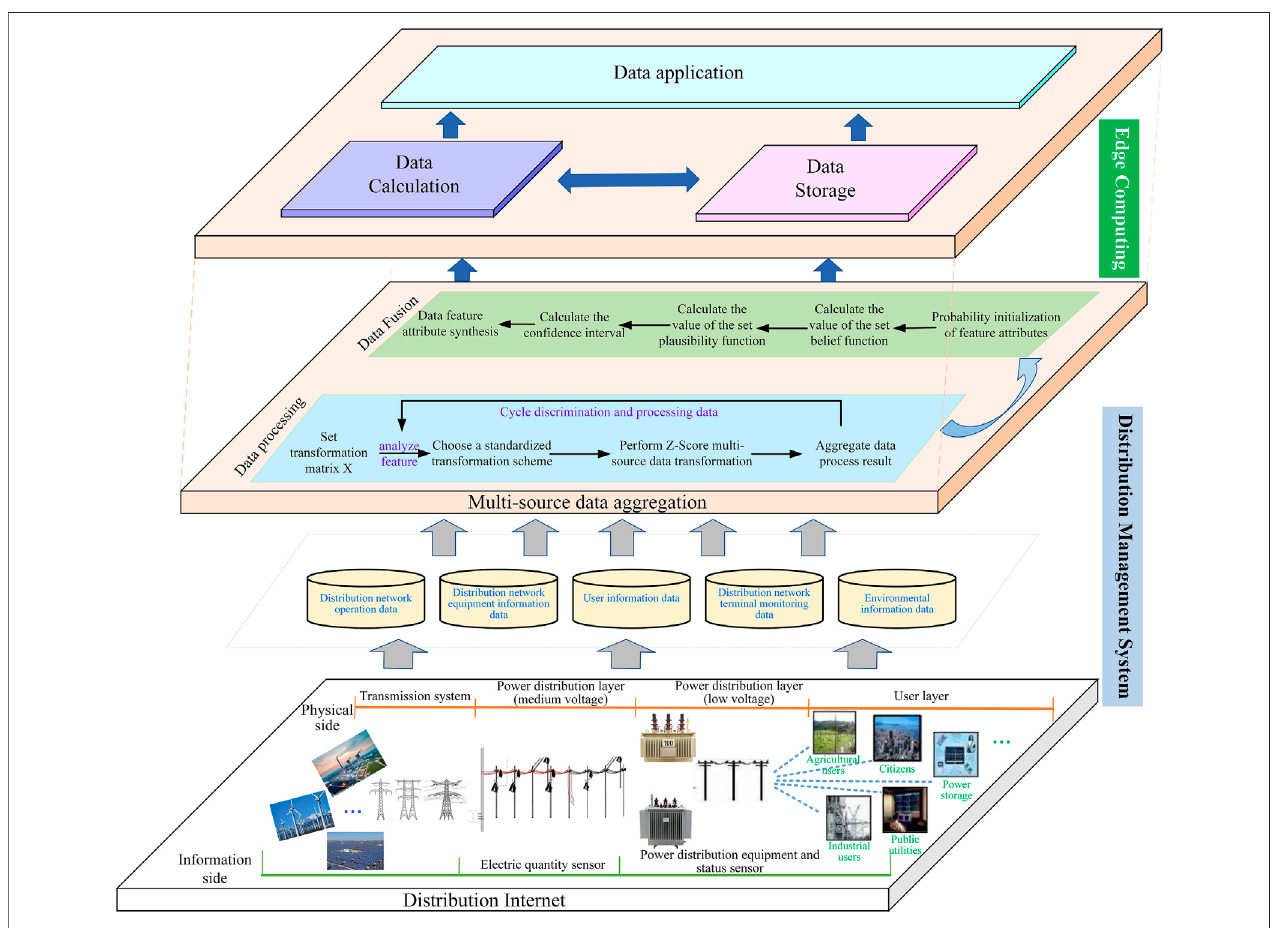
FIGURE 1 | Multi-source data processing and fusion